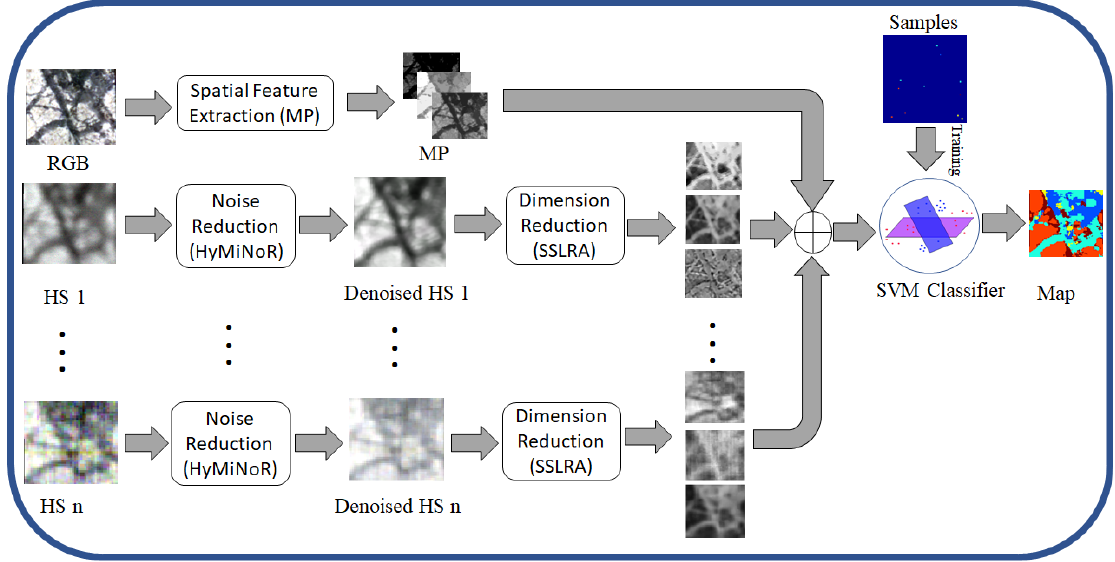
Figure 3. Frame-work of the proposed methodology (MOSFus) for the fusion of optical multi-sensor data for mineral